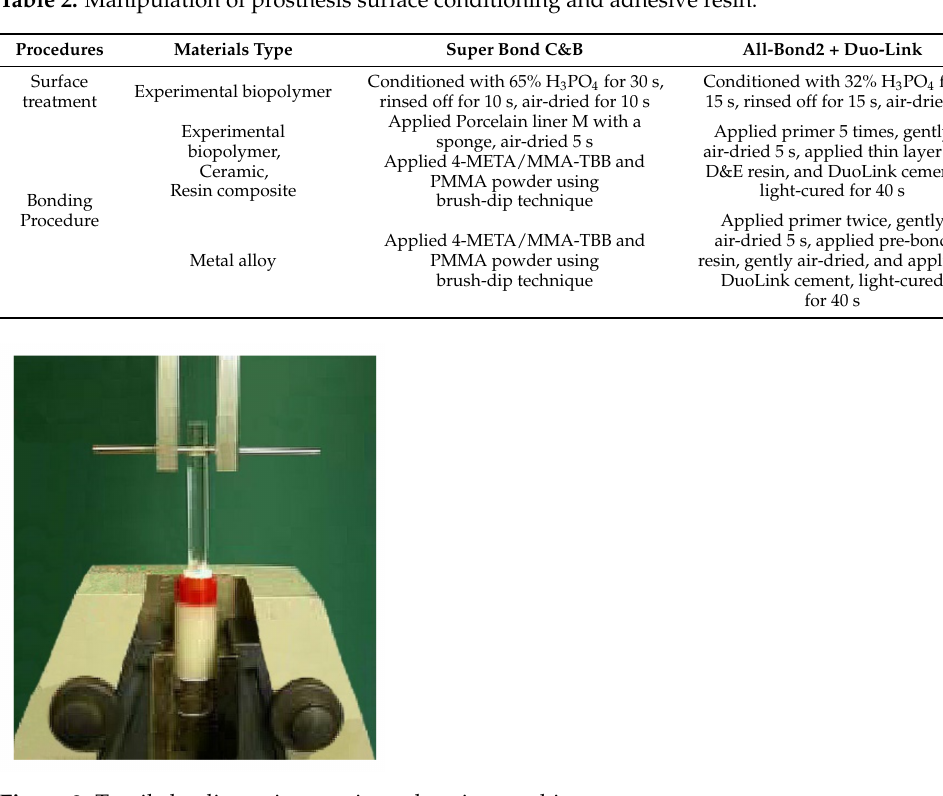
Figure 1. A prosthesis bonded to PMMA rod vertically aligned and loaded using a surveyor. Table 2. Manipulation of prosthesis surface conditioning and adhesive resin.